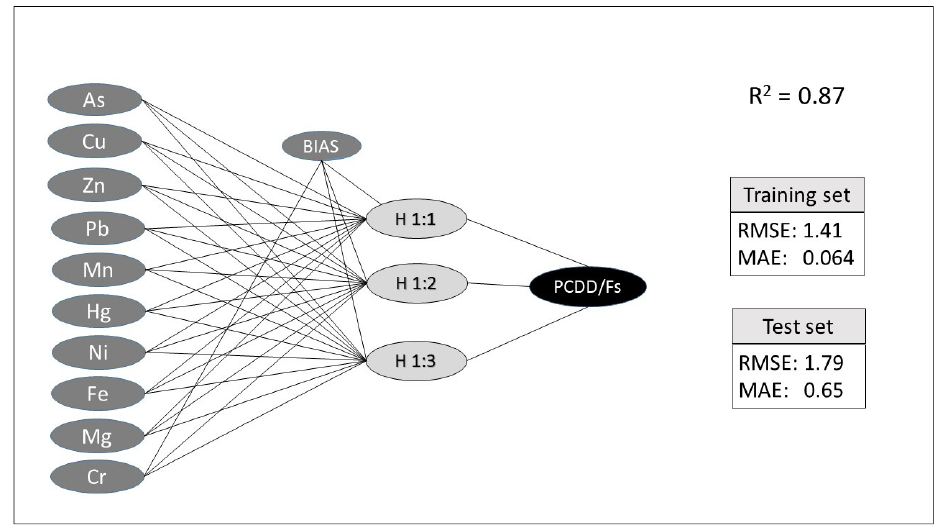
Figure 3. MLP feed-forward network 10-3-1. Input variables have been standardized. The training rate set was 70.3%. Activation functions were hyperbolic tangent for hidden nodes and identity function for output nodes. The prediction error has been minimized across ten epochs. The RMSE and MAE values in the training and test set are of the same order, even if not remarkably low, and R 2 is 0.87. The network provides reliable predictions.